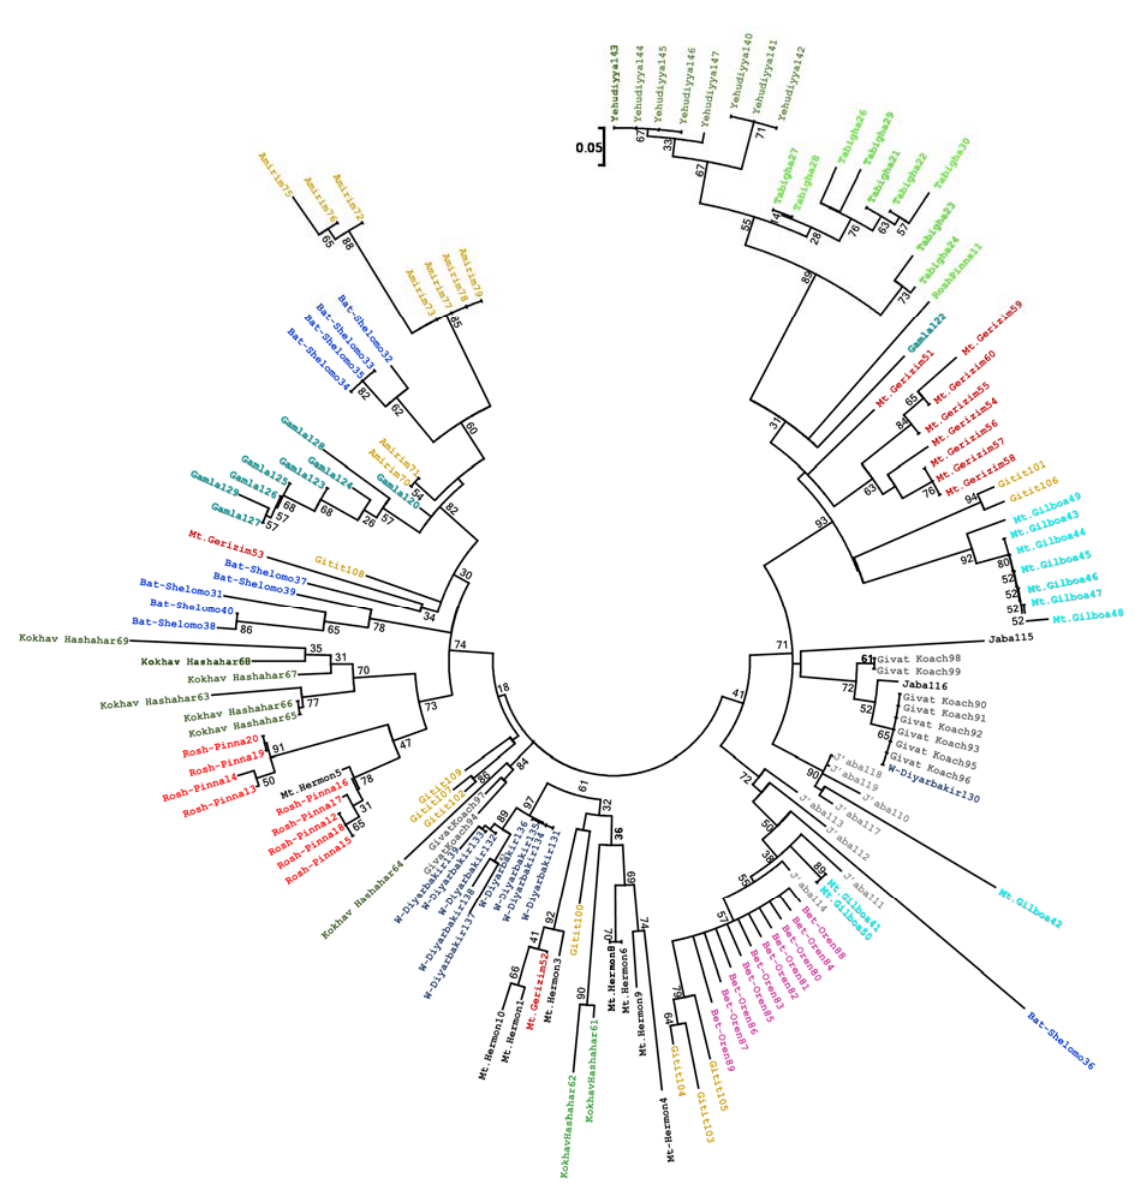
Figure 4. A phenogram obtained for the WEW populations. Bootstrap percentages are shown adjacent to the nodes. The population names appear at the branch ends, colored consistently with those in Figure 5. Populations are described in Table 1.